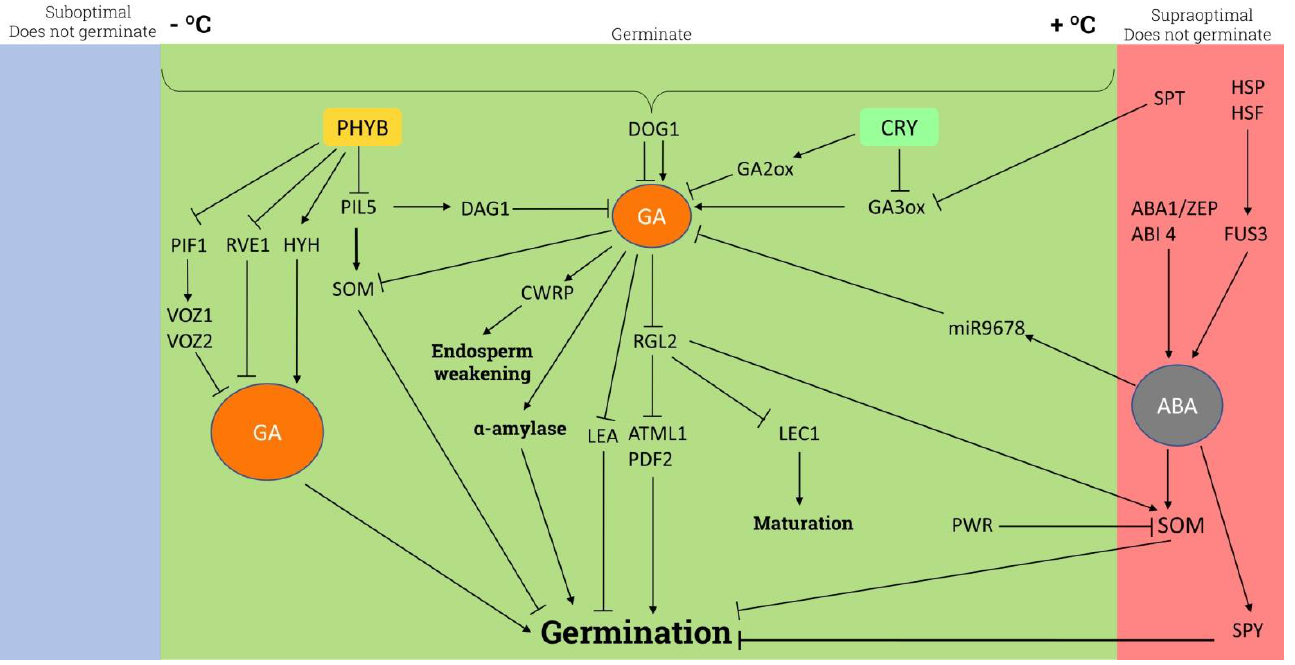
Figure 3. Schematic representation of the GA-related signaling involved in seed germination. Ar- rows indicate activation and blunt-end lines indicate repression or inhibition. See text for details